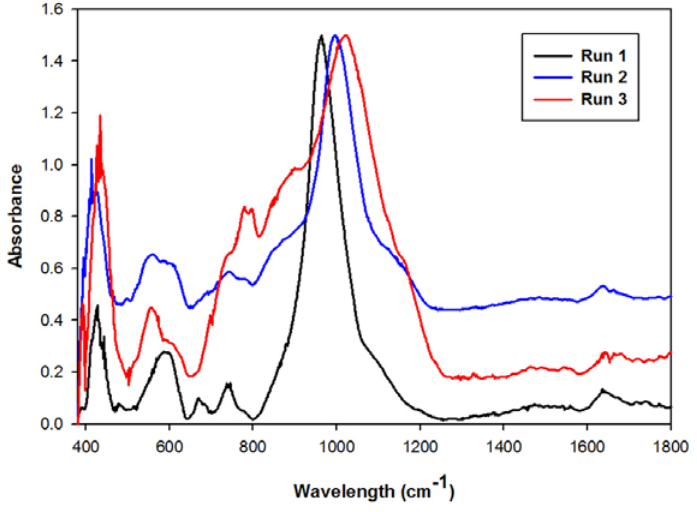
Figure 4. Infrared spectra of products obtained after recycling the supernatant waste as a source of